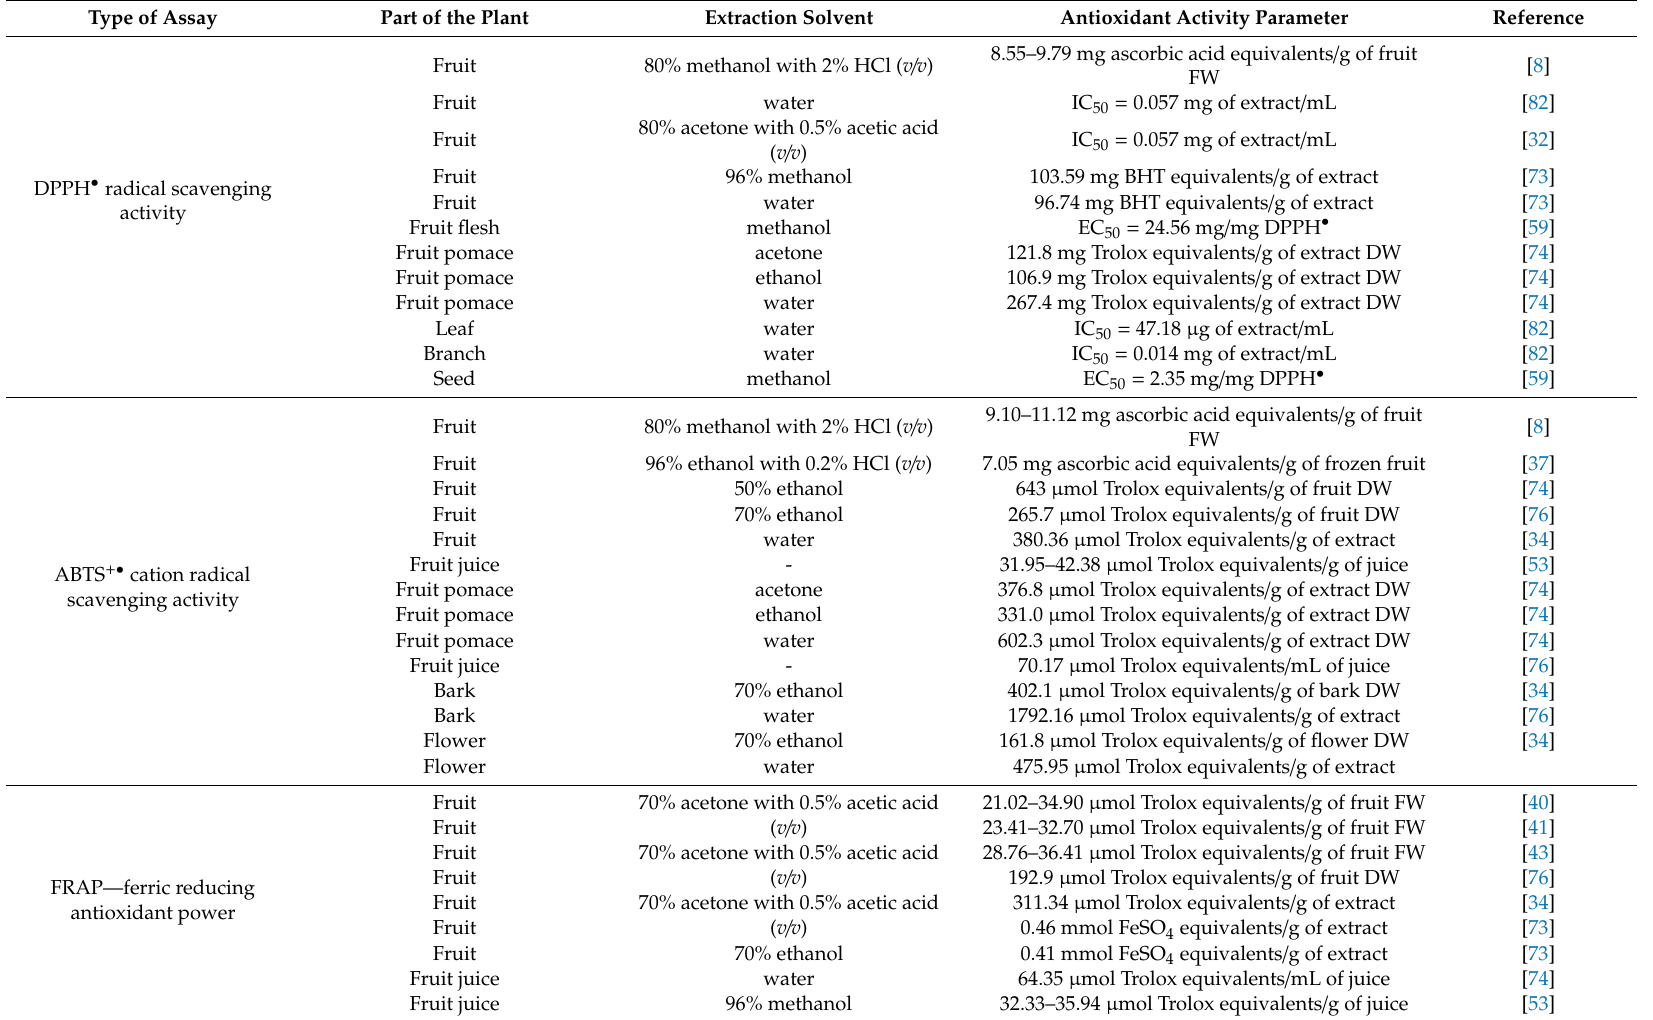
Table 5. Antioxidant capacities of Viburnum opulus leaf, branch, bark seed, and flower determined by single electron transfer (SET) or ET